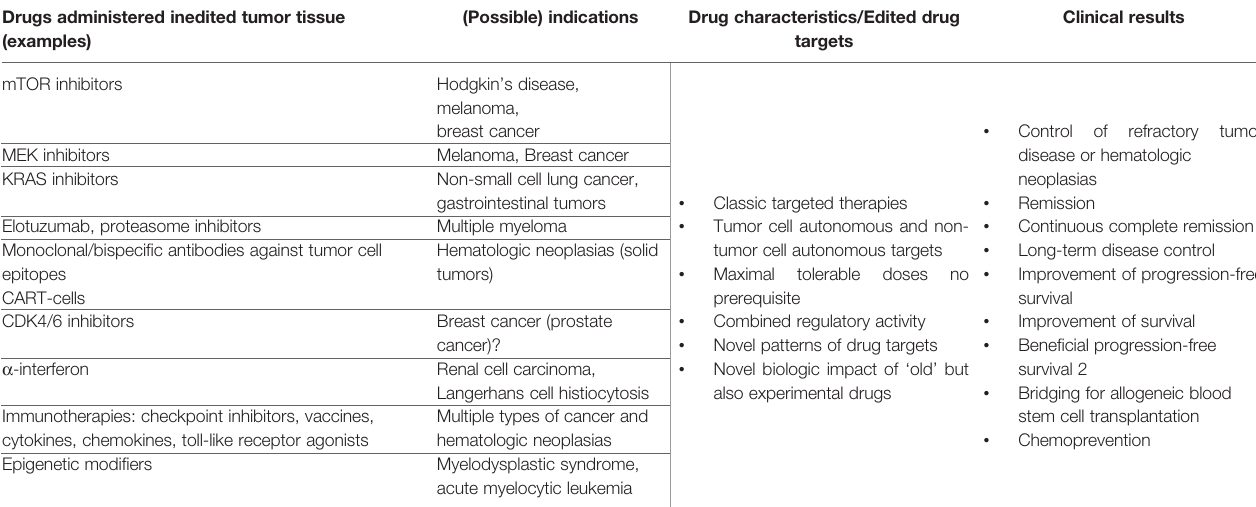
TABLE 2 | Drug repurposing in edited tumor tissue; possible matching drug and tumor diseases ’ systems state by drug repurposing. Drugs administered inedited tumor tissue